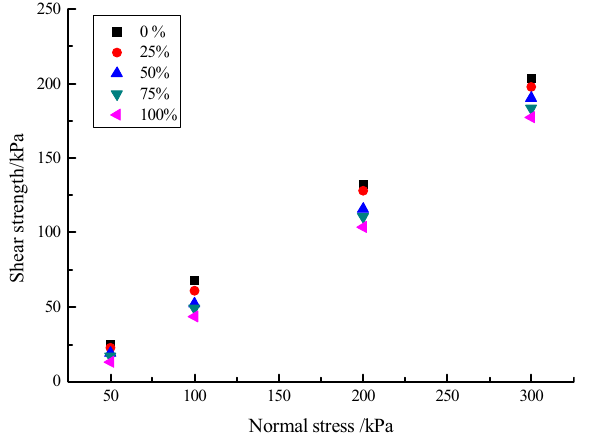
Figure 1. Relationship between shear strength and normal stress of tailings under different oxidation degrees.